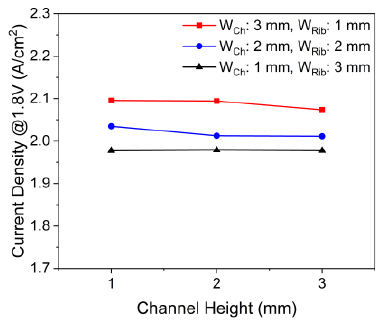
Figure 11. Effects of channel width-to-rib width ratio and channel height on PEMWE’s current density ( ε : 0.75, K : 30.2 × 10 −12 m 2 , θ : 30°, 𝑄̇ 𝑖𝑛 : 10 sccm, T in : 328.15 K, T cell : 328.15 K, V op : 1.8 V and 𝑔 : z+).